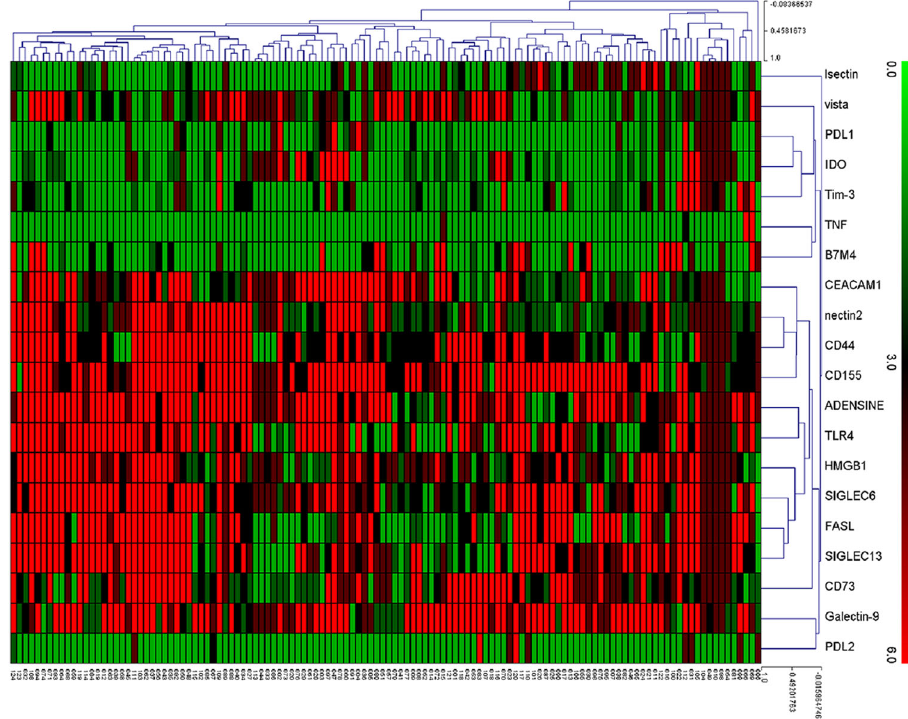
Fig. 1 A heat map presenting data on 20 immune checkpoints from a TMA containing 124 GC patient samples. The abscissa represents the patient number of 124 patients in the TMA, and the ordinate represents the expression of LSECtin, VISTA, PD-L1, IDO, TIM-3, TNFRSF14, B7M4, CEACAM1, NECTIN2, CD44, CD155, ADENOSINE, TLR4, HMGB1, SIGLEC6, FAS-L, SIGLEC15, CD73, Galectin-9 and